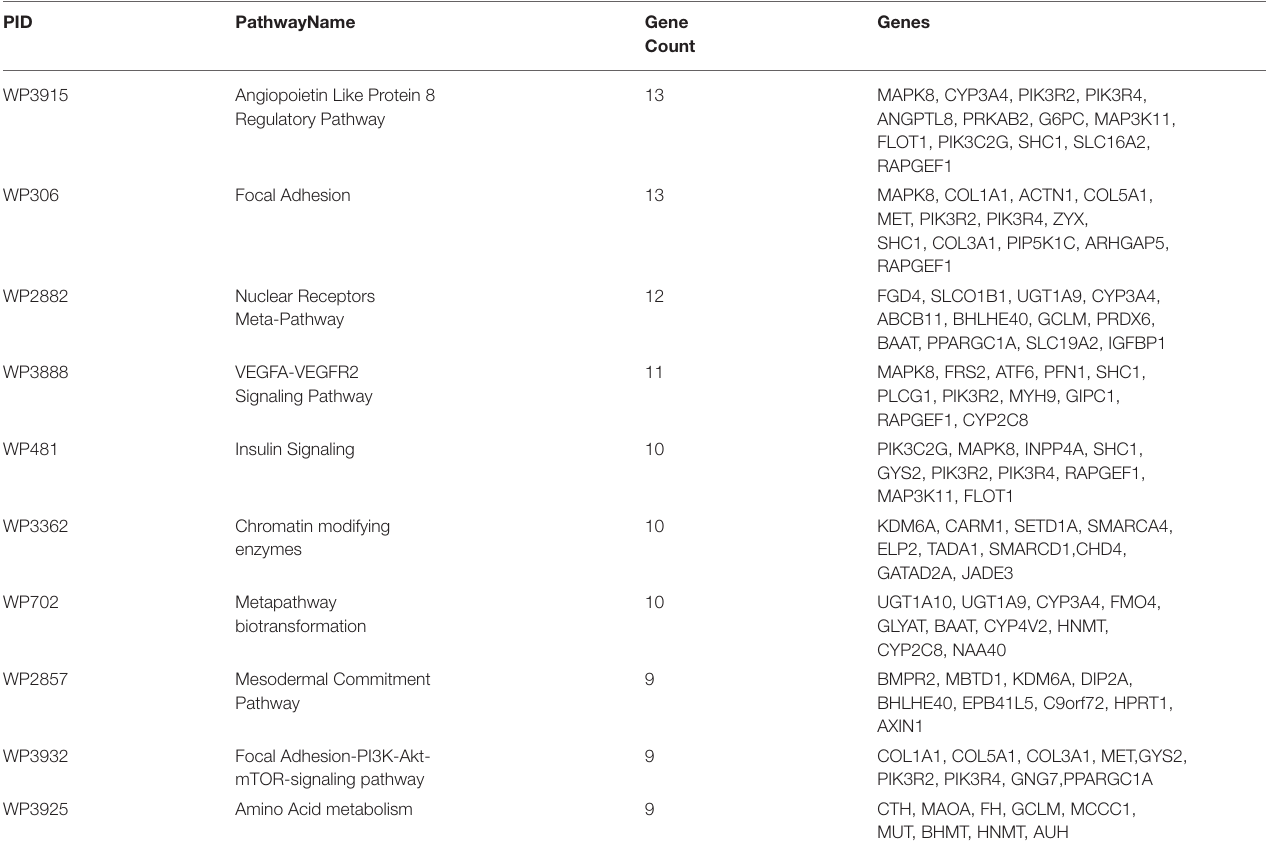
TABLE 3 | Top 10 pathways in gene-pathway co-expression network: The maximum number of ANGPTL8 associated co-expressed genes identified in WikiPathways along with respective gene symbols are listed.